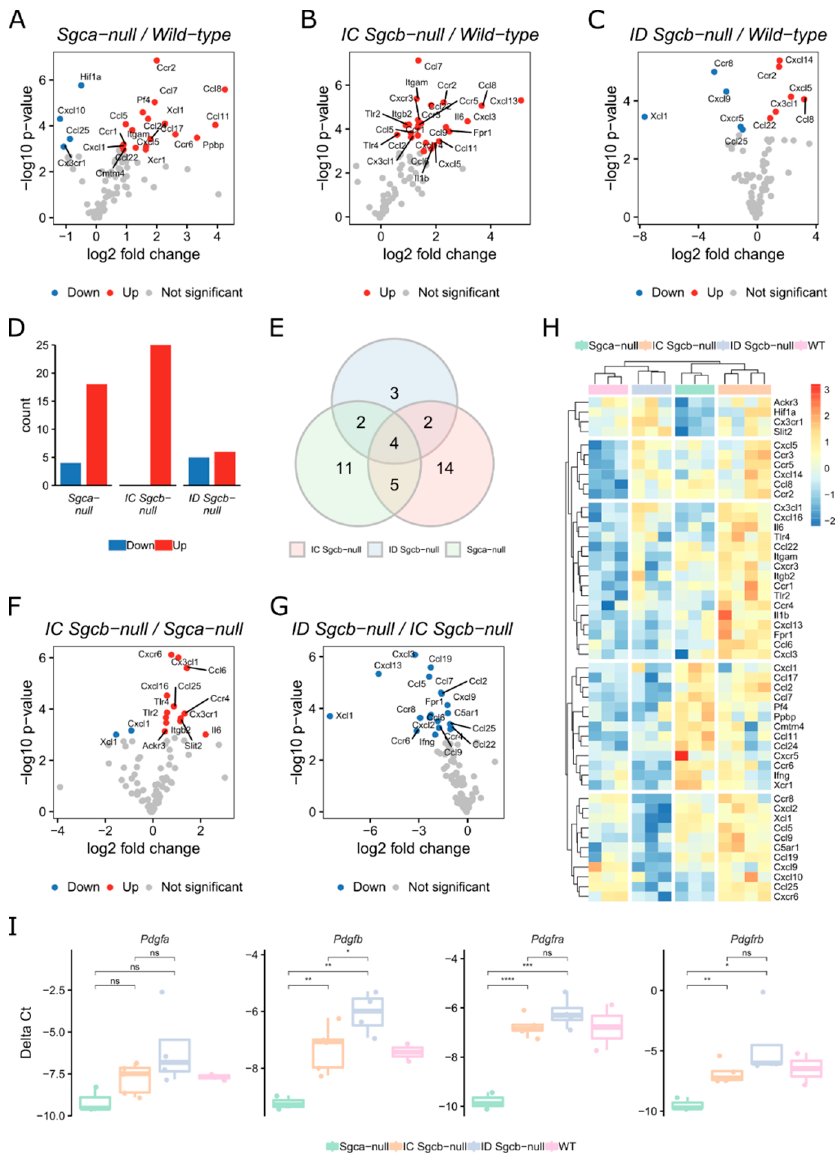
Figure 2. Comparison of chemokine expression in the hearts of different dystrophic animal models. Volcano plot of chemokine expression analysis on the hearts of Wild-type versus Sgca -null ( A ), IC (immunocompetent) Sgcb -null ( B ) and ID (immunodeficient) Sgcb -null ( C ). ( D ) Quantification of significant up- and down-regulated genes of ( A – C ). ( E ) Venn diagram comparing the significant differentially expressed genes of ( A – C ). ( F ) Volcano plot of chemokine expression analysis on the heart of IC Sgcb -null versus Sgca -null mice. ( G ) Volcano plot of chemokine expression analysis on the heart of ID Sgcb -null versus IC Sgcb -null mice. ( H ) Heatmap (blue-to-red) showing Z-score of significant genes from ( A – C , F , G ); hierarchically clustered rows and columns. ( I ) qPCR analysis of Pdgf genes; values shown as Delta Ct normalized to Rpl13a . n = 2–5. In ( A – C , F , G ), significant differentially genes ( p ≤ 0.05) are coloured blue (downregulated) and red (upregulated). Genes are normalized to housekeeping genes ( Actb , Gusb , Gapdh and Hsp90ab1 ). n = 3–4, t -test. * p ≤ 0.05, ** p ≤ 0.01, *** p ≤ 0.005, **** p ≤ 0.001, t